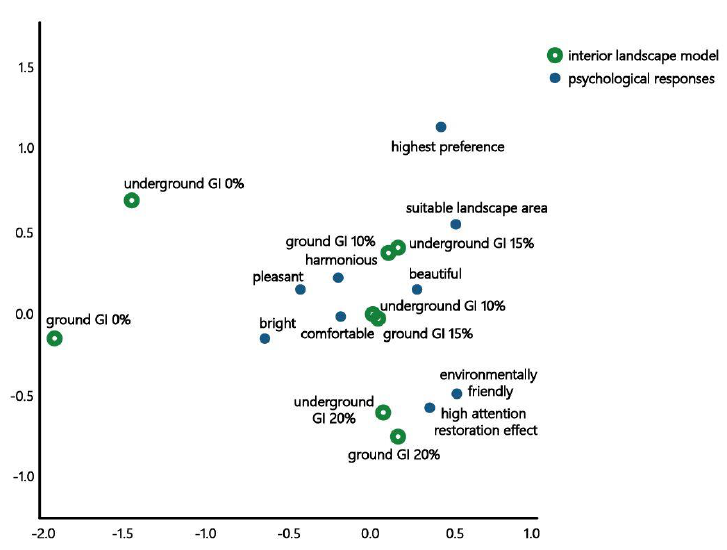
Figure 5. Positioning Map Between the Interior Landscape Model and Psychological Responses of the Subjects of the Survey According to the GI.